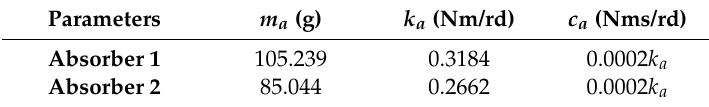
Table 3. Parameters of the designed pendulum